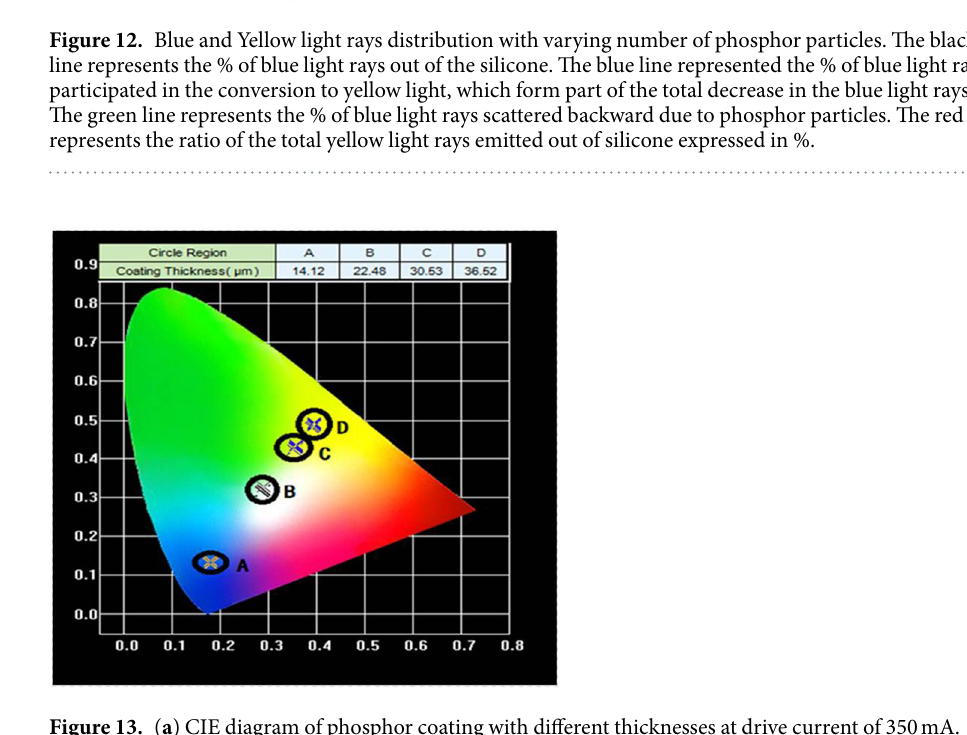
Figure 13. ( a ) CIE diagram of phosphor coating with different thicknesses at drive current of 350